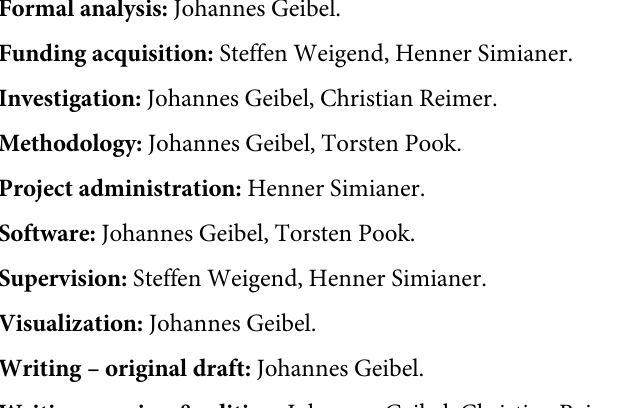
S8 Fig. OHE for discovery validation and application populations after the five steps of array design. Discovery populations are chosen to represent populations which are compara- ble to the original array (blue) or 50 times random sampled (grey). S9 Fig. Relation of the OHE as a function of the number of discovery populations. A—dis- covery, B–cluster removal, C–equal spacing, D–validation, E–downsampling. The Boxplots are only shown for a subset of the number of discovery populations, while the smoothing lines, which show the trend, are calculated from all observations. S1 Table. Number of SNPs from the remodeling processes. S2 Table. Pearson correlations between the H of the different SNP exp